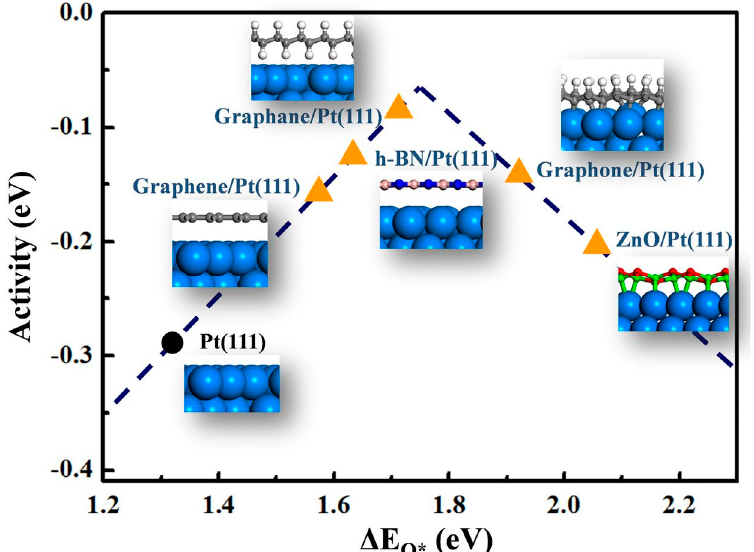
Figure 4. The volcano curve relation between ORR activity and binding energies of O atoms ( Δ EO*) on Pt surface. Insets demonstrate the interfacial structures. B, purple balls; C, gray balls; H, white balls; N, dark blue balls; O, red balls; Pt, light blue balls; and Zn, green balls. Reprinted (adapted) with permission from [26]. Copyright (2017) National Academy of Sciences.